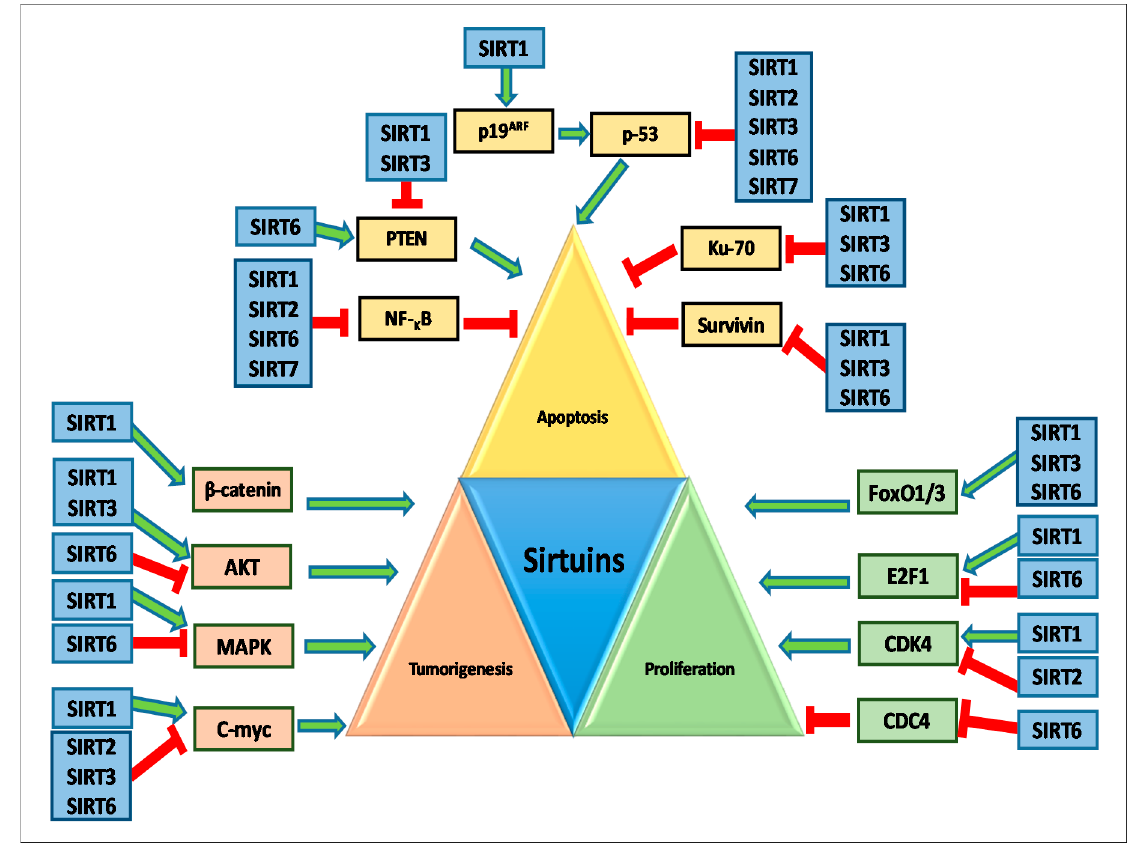
Figure 5. Role of SIRTs in cell proliferation, apoptosis, and tumorigenesis. AKT–protein kinase B; CDC4–cell division control protein 4; CDK4–cyclin-dependent kinase 4; C-myc–transcription factor; E2F1–transcription factor E2F1; FoxO1/3– forkhead family of transcription factors; Ku70–protein Ku; MAPK mitogen-activated protein kinase; NF- κ B–transcription nuclear factor κ B; PTEN–phosphatase and tensin homolog deleted on chromosome Ten; p19ARF–ARF tumor suppres-